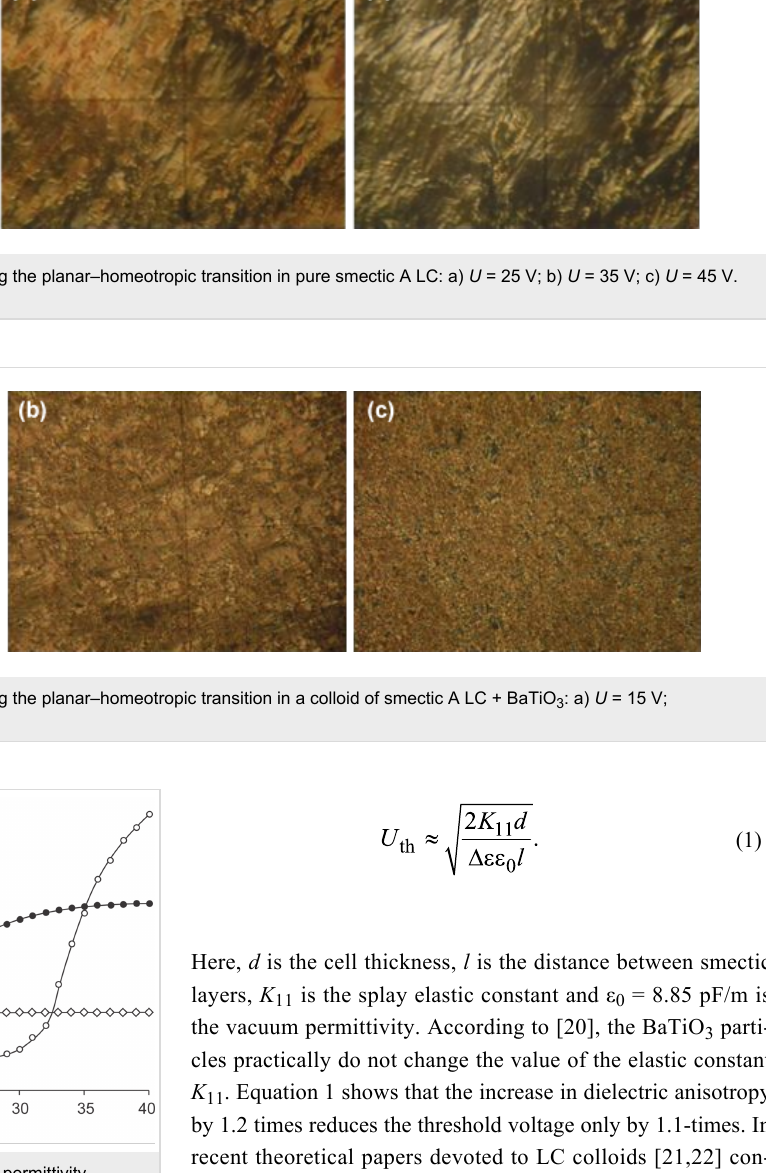
Figure 3: Voltage dependence of effective dielectric permittivity. Circles: pure smectic A LC; filled circles: smectic A LC + BaTiO 3 col- loid in the smectic A phase; diamonds: smectic A LC + BaTiO 3 colloid in the crystal